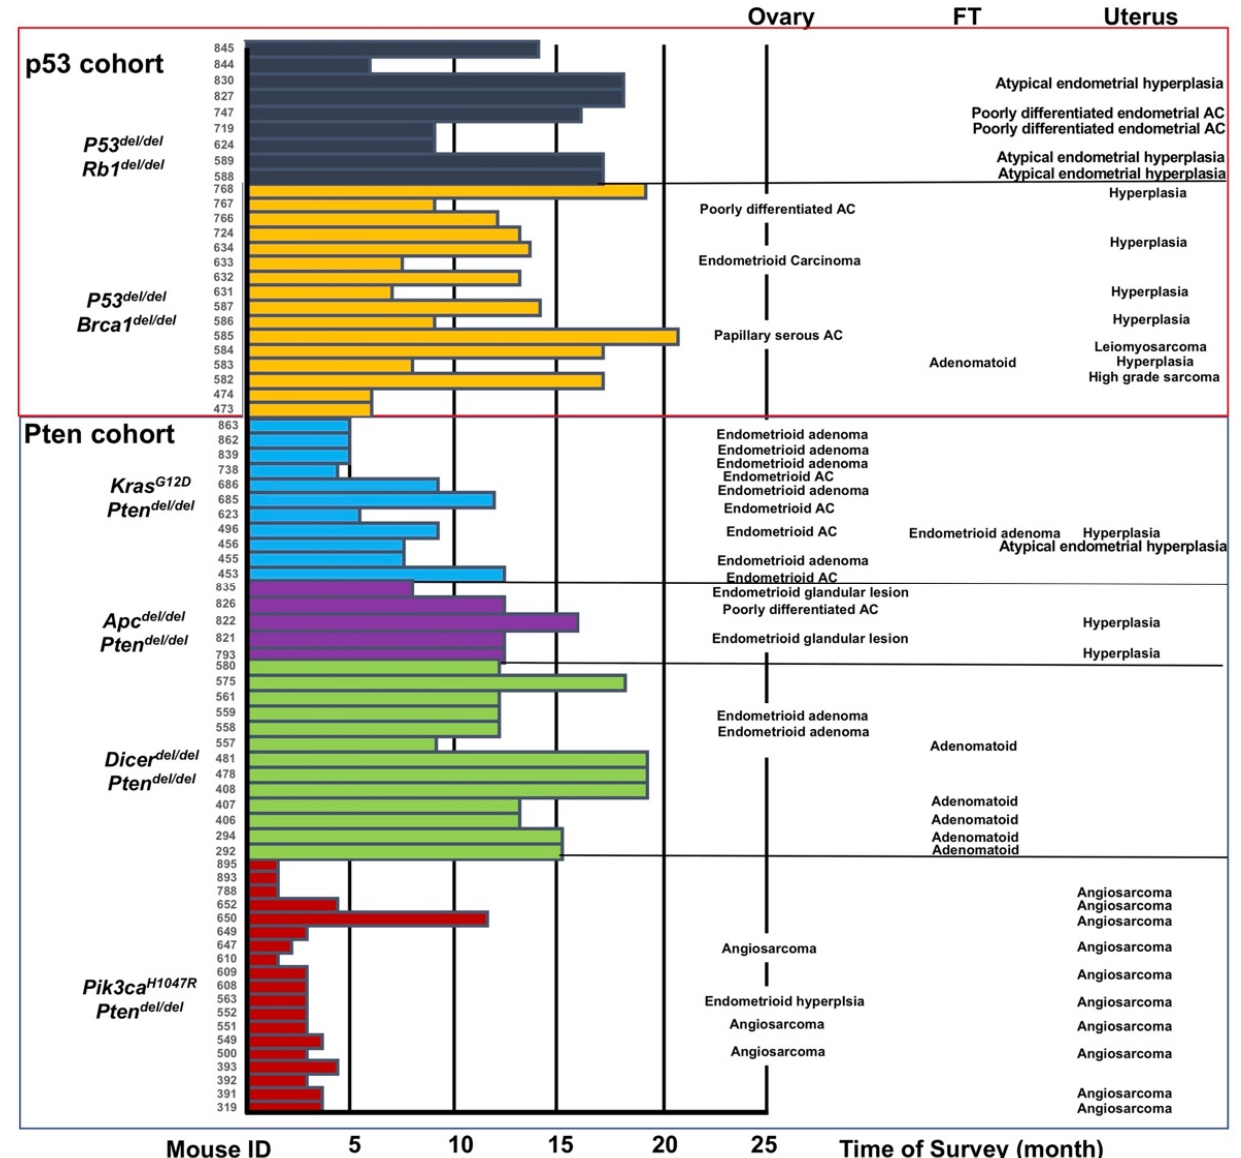
Figure 3. Histological summary of gynecological malignancies induced by the intrabursal injection of Ad-K8-Cre to various mouse models. The histogram indicates the time of the survey of individual mice. Lesions and phenotypes are shown in the corresponding tissues. The same color indicates the same mouse model. FT: fallopian tube; AC: adenocarcinoma; del: deletion.